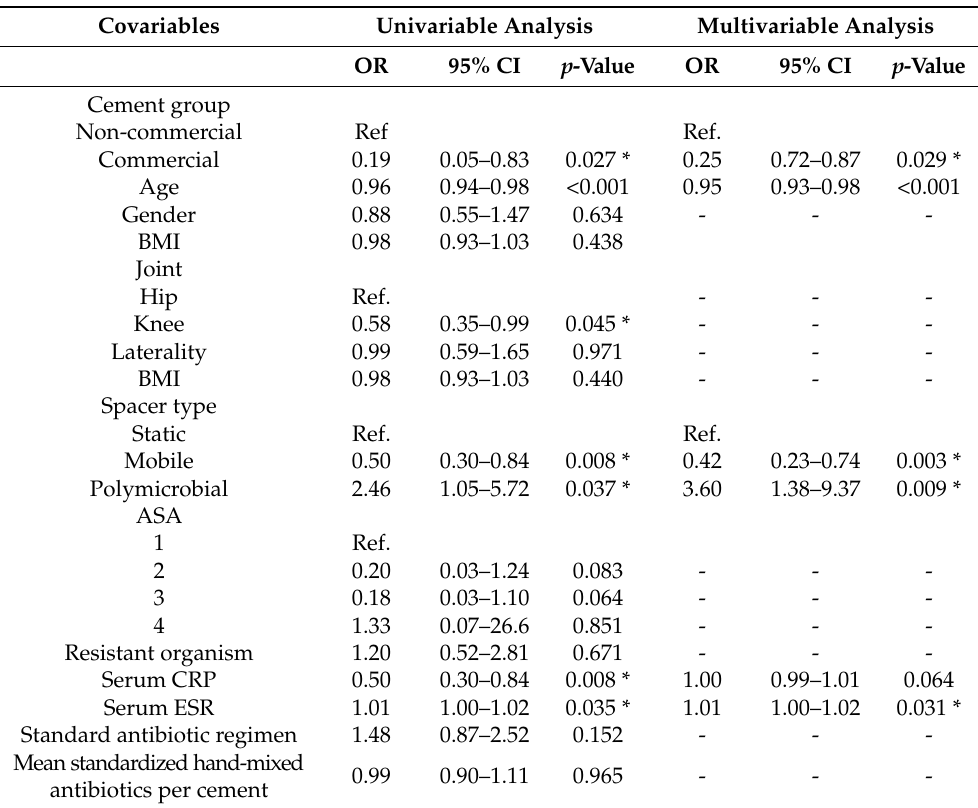
Table 2. Univariable and multivariable analysis of the spacer exchange for periprosthetic joint in- fection.